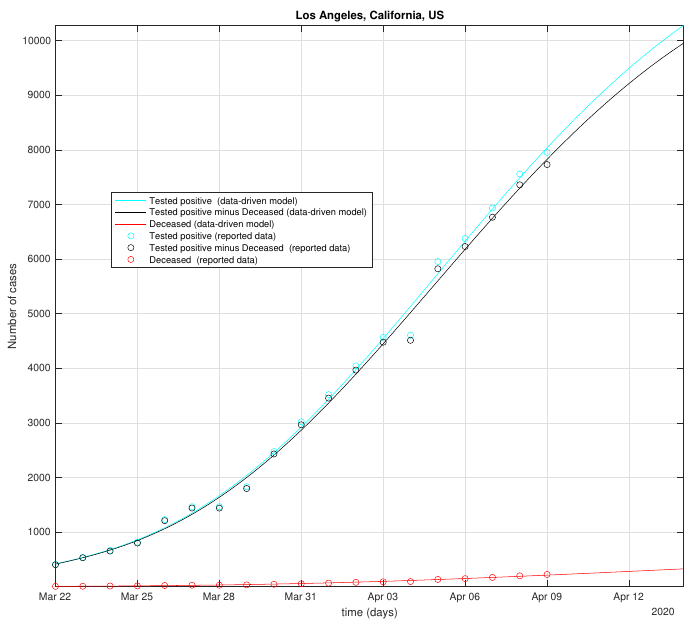
Figure 15. New York and Los Angeles testing results: data vs.